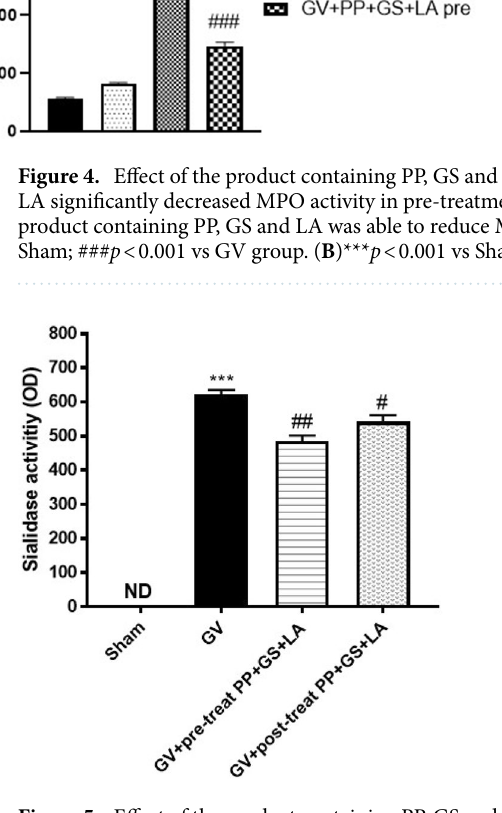
Figure 5. Effect of the product containing PP, GS and LA on sialidase activity. The product containing PP, GS and LA significantly decreased sialidase enzyme activity compared to GV infected mice group in pre-treatment and post-treatment conditions. *** p < 0.001 vs Sham; # p < 0.05 vs GV group; ## p < 0.01 vs GV group.